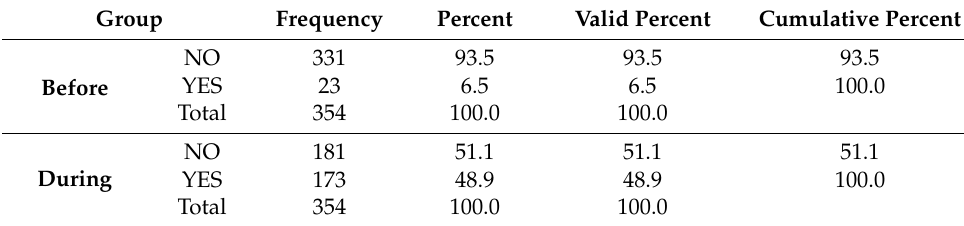
Table 2. Correlation between anxiety state and presence of GISs.